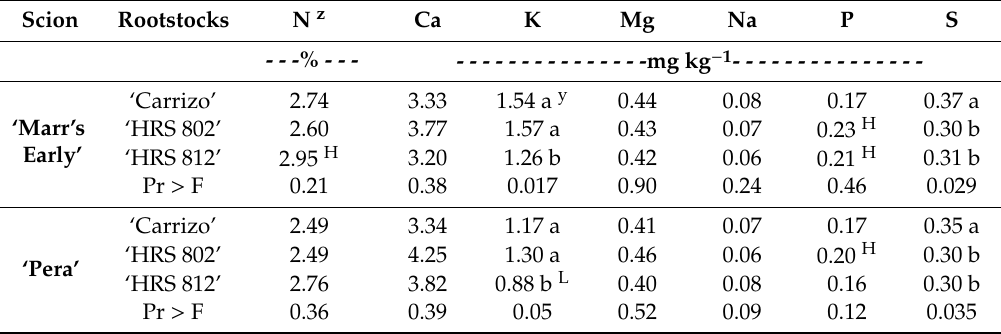
Table 2. Mean concentrations of leaf tissue nutrients in 2016 of two sweet orange cultivars growing in Alonso clay series soil grafted on three di ff erent rootstocks at the Agricultural Experiment Station of Adjuntas, Puerto